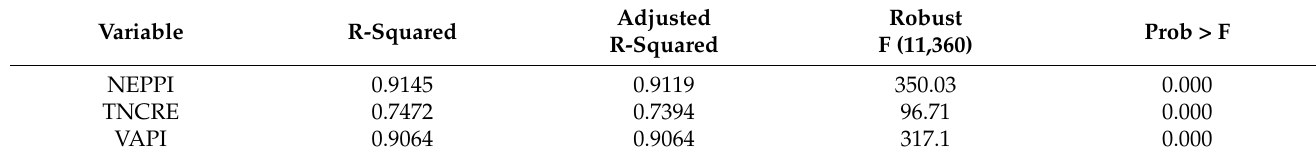
Table 11. Results of the weak instrumental variable